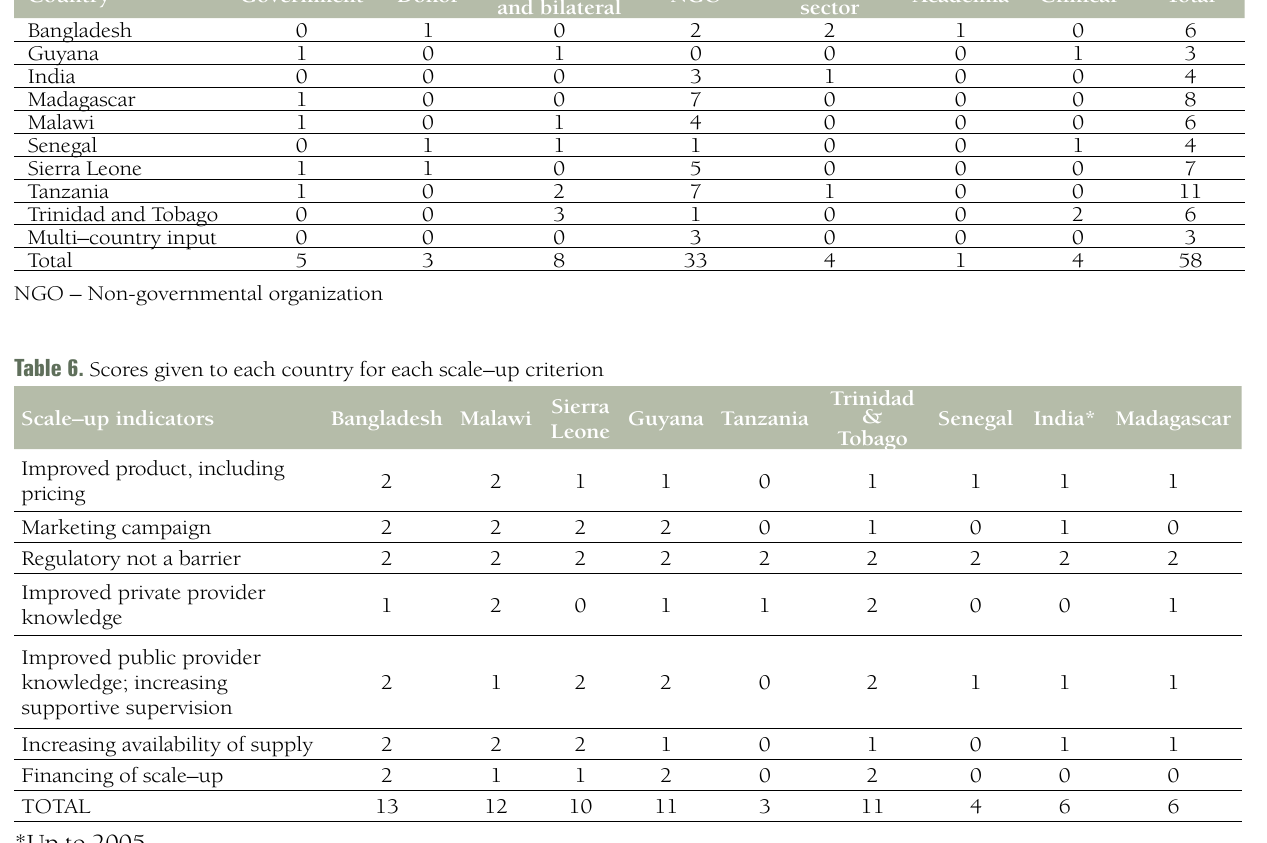
Table 5. Number and type of key informants accessed for each country Country Government Donor